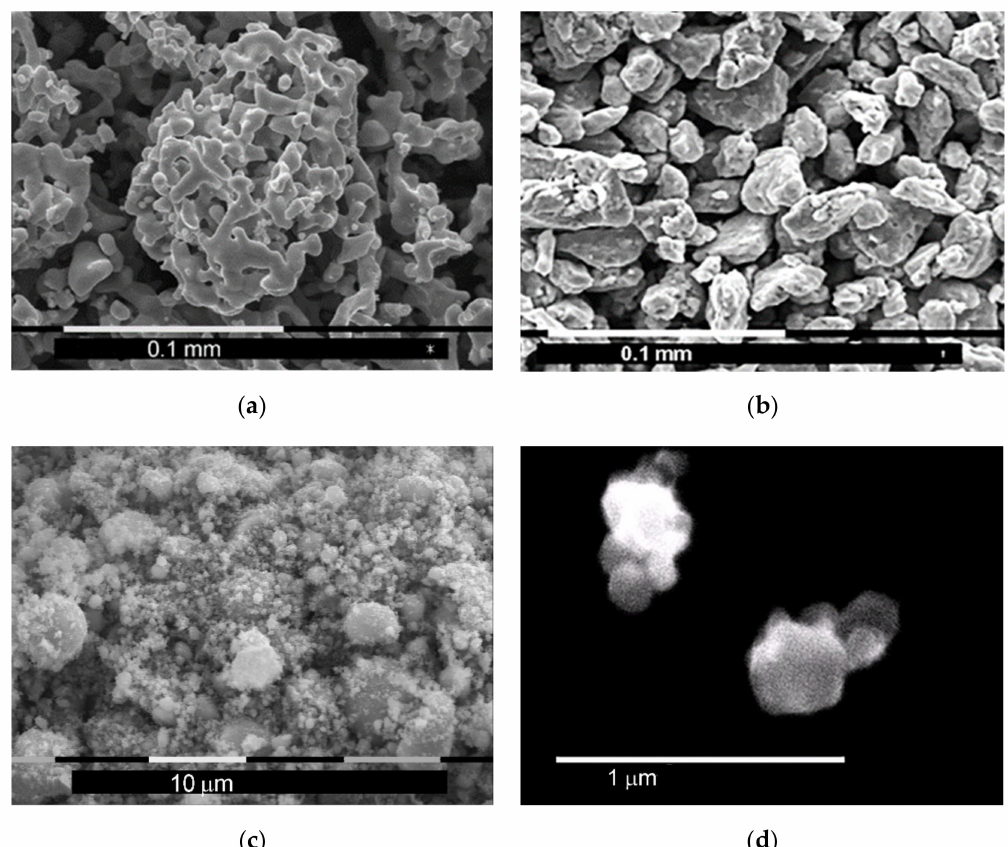
Figure 8. Morphology of titanium powder as a function of the MA time, min: ( a ) 0, ( b ) 10, ( c ) 40, ( d ) microphotograph of titanium nitride particles obtained by mechanochemical synthesis, data from [29].